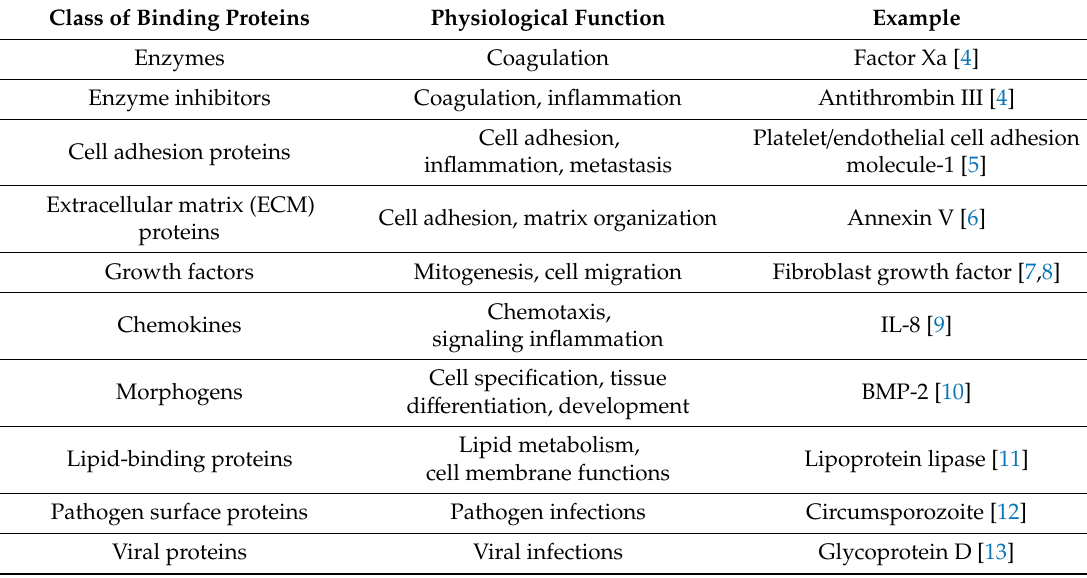
Figure 1. Major disaccharide repeating units of different types of GAGs (R = H or SO 3 − and R 1 = H, or SO 3 − , or COCH 3 − ). Table 1. Different classes of GAG-binding proteins and their biological activities.